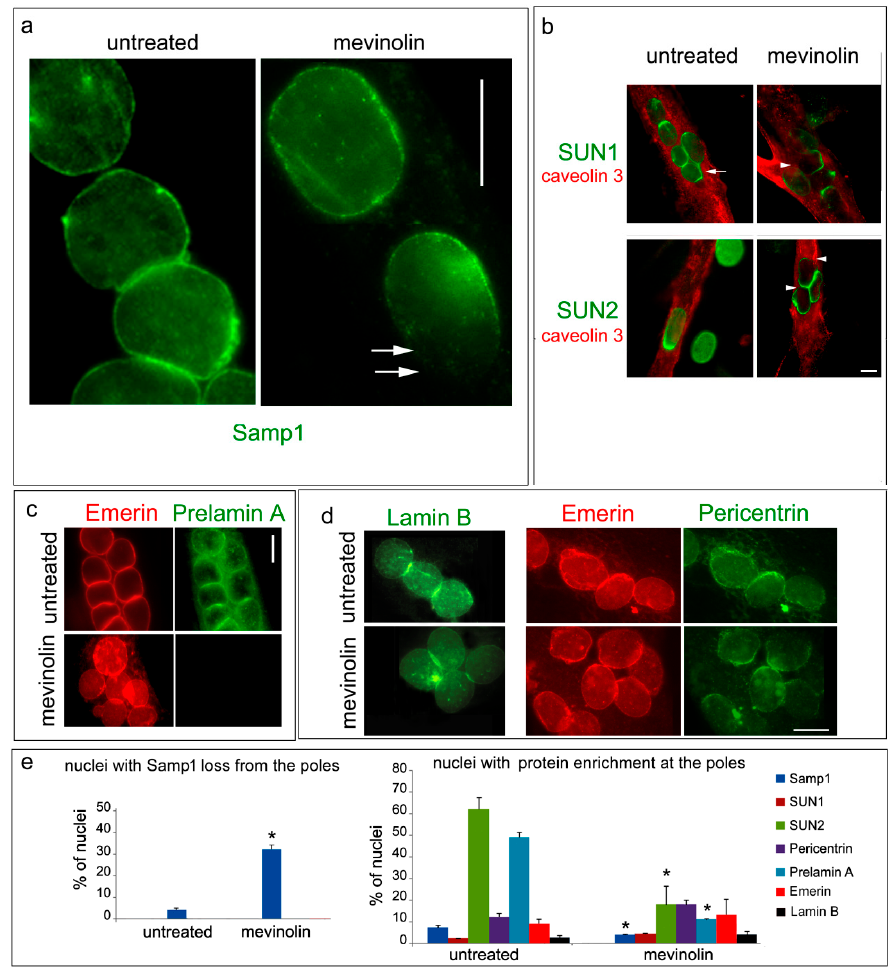
Figure 2. Loss of Samp1 from the nuclear poles in the absence of farnesylated prelamin A. Human control myotubes left untreated (untreated) or treated with mevinolin (mevinolin) are shown. ( a ) Samp1 staining in myotubes. Arrows show a nuclear pole devoid of Samp1 in a myotube subjected to mevinolin. ( b ) Co-staining of SUN1 or SUN2 with caveolin 3. SUN1 and SUN2 loss from the nuclear poles is observed in mevinolin-treated myotubes. The arrow points to a nuclear pole connected to a nucleus of a fusing myoblast. Arrowheads show protein loss from a nuclear pole. ( c ) Human myotubes co-stained for emerin and farnesylated prelamin A (Diatheva 1188-2 antibody). The antibody used to detect prelamin A is specific for farnesylated prelamin A, which is not detectable in mevinolin treated cells. ( d ) Staining of lamin B ( left panel) and co-staining of emerin and pericentrin ( right panel) in myotubes. ( e ) Quantitative analysis of the percentage of nuclei showing loss of Samp1 staining at the nuclear pole(s) ( left panel) and protein accumulation at the nuclear poles ( right panel) in untreated or mevinolin-treated cells. Mean values of three counts are reported in the graphs. Statistical significance of differences ( p < 0.05) is indicated by an asterisk (*). Scale bars, 10 µm.